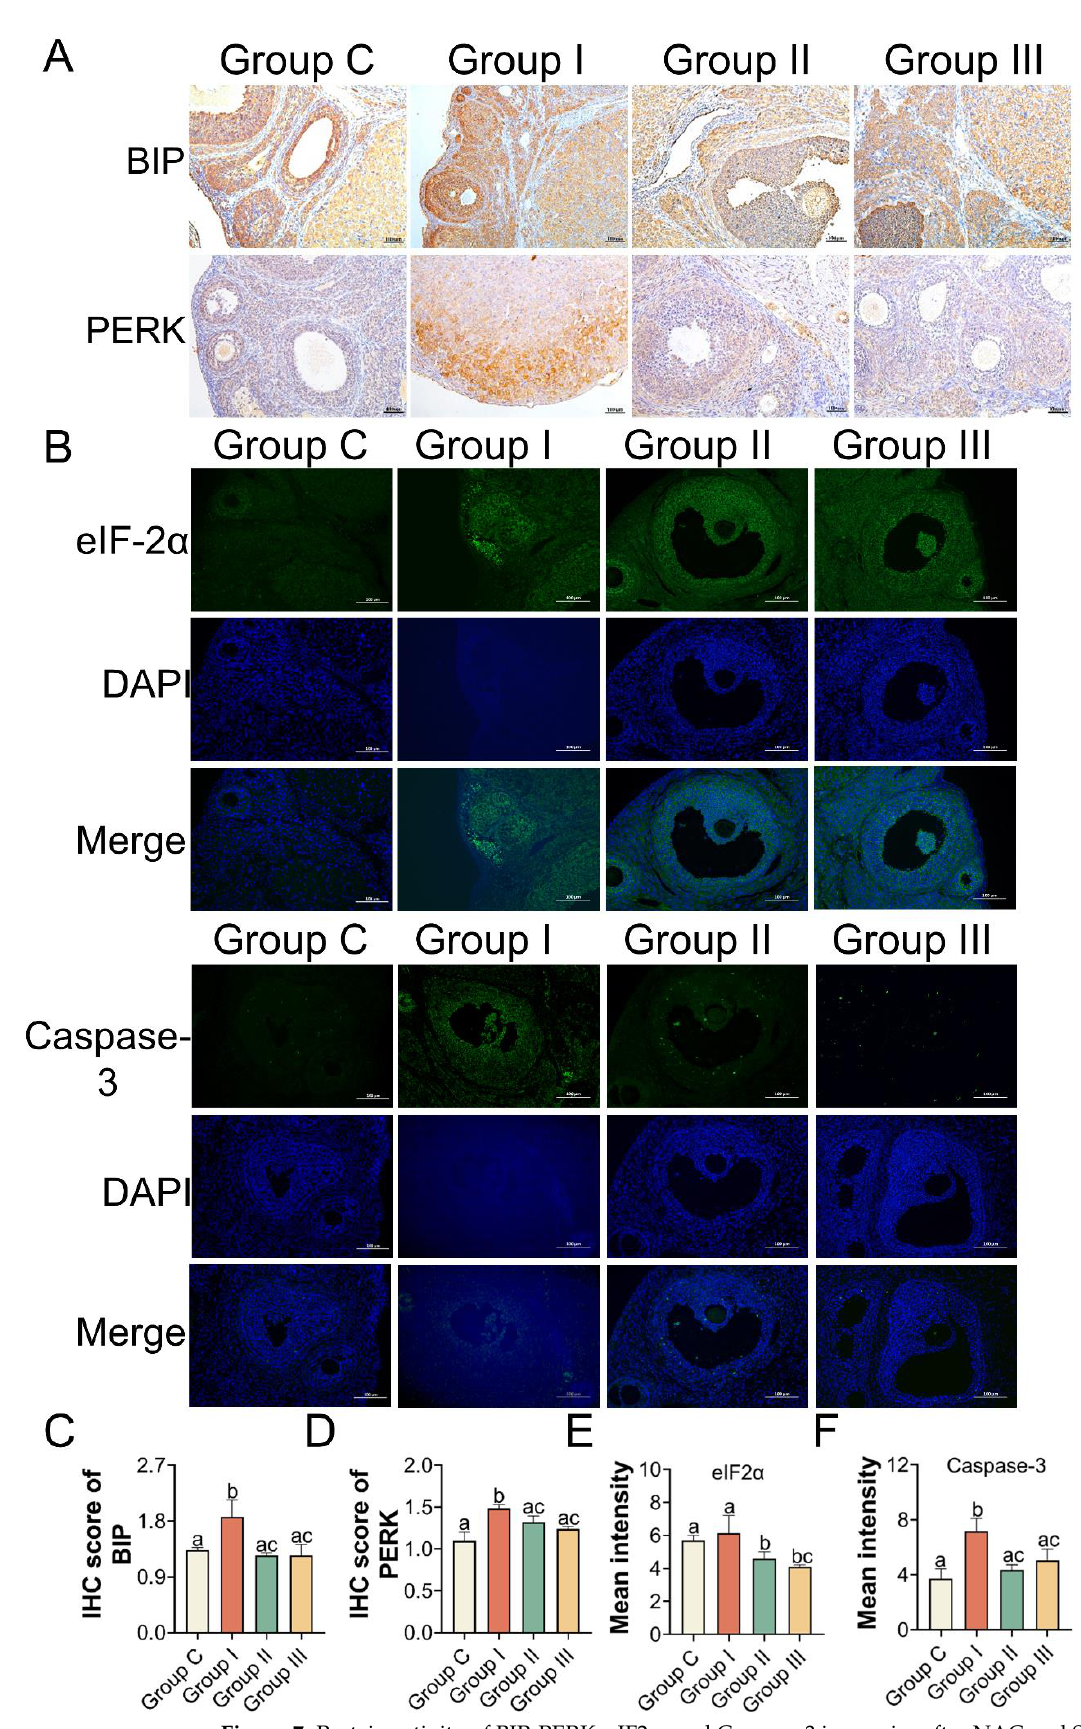
Figure 7. Protein activity of BIP, PERK, eIF2 α , and Caspase-3 in ovaries after NAC and Sal treatment. ( A ) IHC images of BIP and PERK (scale bar = 100 µ m). ( B ) eIF2 α and Caspase-3. Blue: DAPI,